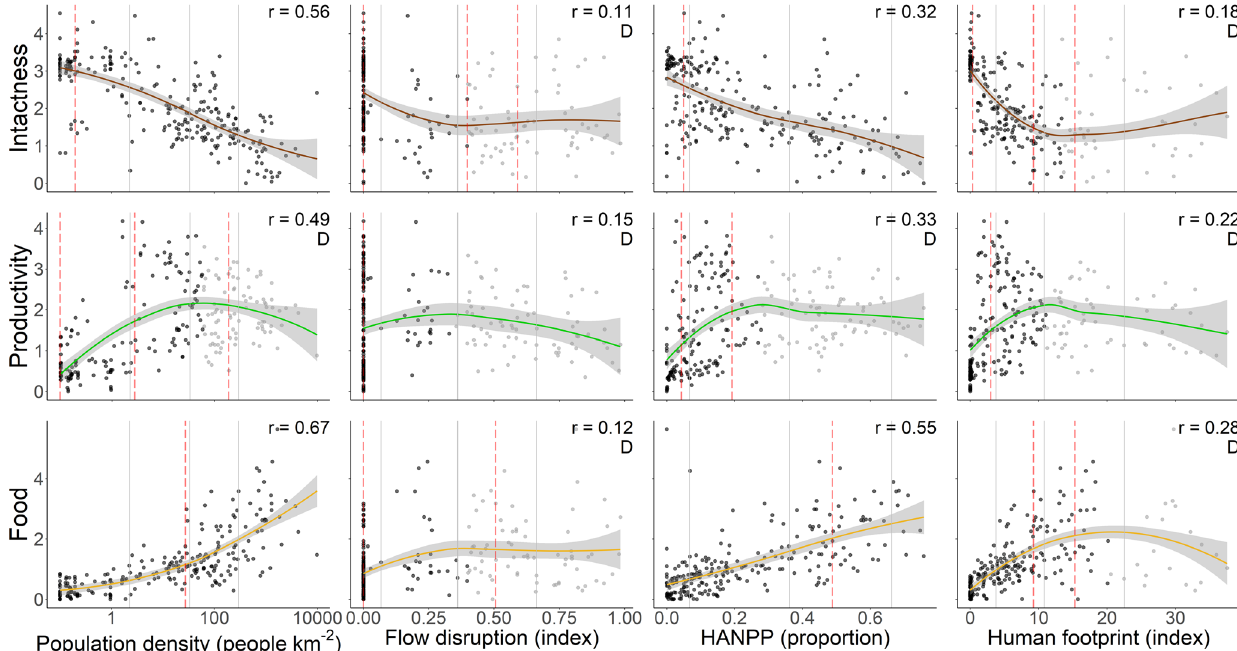
Fig. 2 General relationships between the three robust ecosystem service bundles ( ‘ intactness ’ , ‘ productivity ’ and ‘ food ’ ) and the four types of human modi fi cation. See Table 3 for the composition of each bundle. Each point represents the averaged values of the most recently available indicators for one delta. y-axes show a scaled sum of the ecosystem service components of each bundle. The presence of a change-point in a trend line indicates decoupling, highlighted by the label D; beyond this point delta data points are coloured grey. The trend line shows a LOESS regression with a span of one. ‘ r ’ indicates pseudo r-value, the fi t of this regression based on sum of squared residuals. Trend line colour indicates ecosystem service bundle and is consistent across the fi gures. Shaded areas around trend line indicate 0.95 CI. Grey vertical lines show bin edges in modi fi cation data, calculated with breakpoint analysis. Red dashed lines show breakpoints between one regression relationship and another between the modi fi cation and ecosystem service indicators. Overall, we fi nd a consistency in the breakpoints across the relationships examined, i.e. that relationships change at the similar levels of modi fi cation.